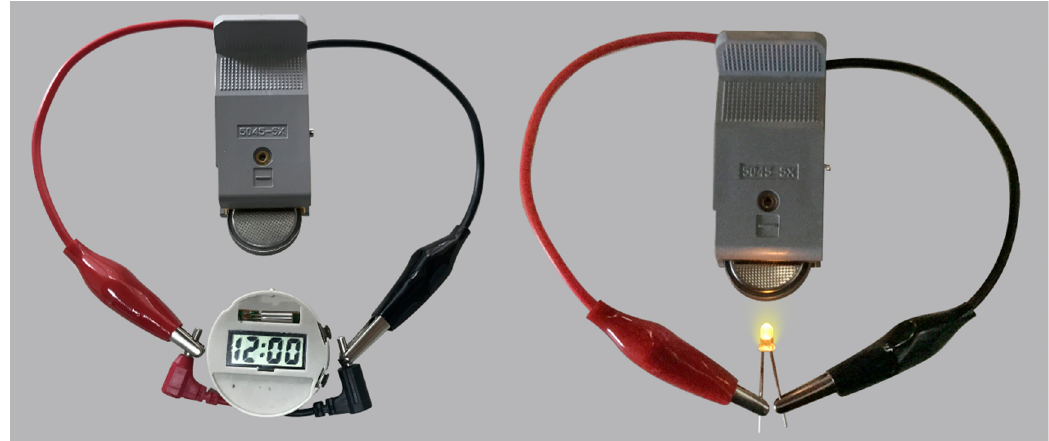
Figure 5. A test of a CuS/Cu 1.8 S nanocomposites half-cell after 1000 cycles illuminating an electronic watch and a LED lamp.